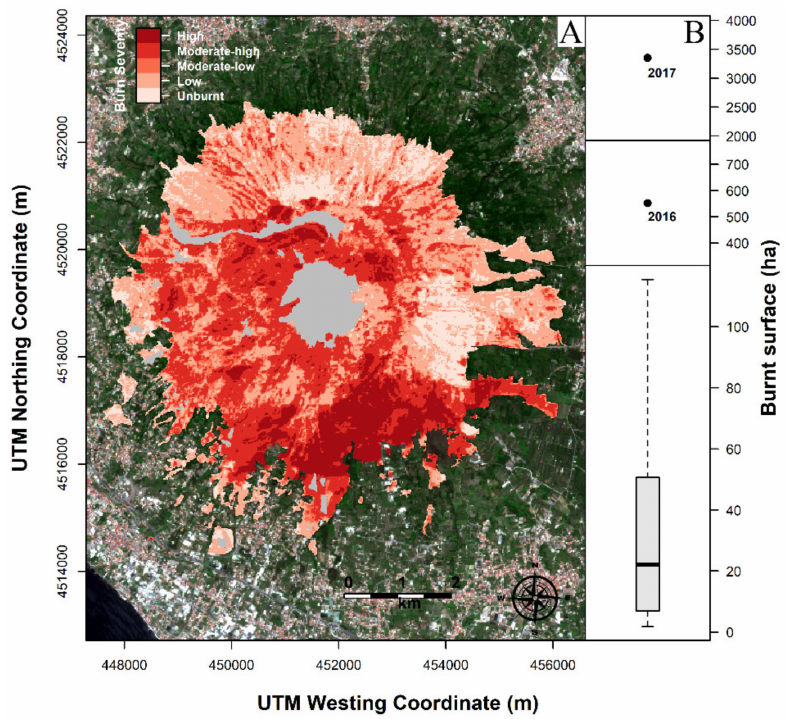
Figure 2. Burn severity map of the wildfires that occurred in summer 2017 (panel ( A )). On the right box plot of 20-year historical data for the annual burnt surface area from 1997–2017 in the forest area of Vesuvius National Park (panel ( B )). The outliers in 2016 and 2017 can be classified as megafires, according to DellaSala and Hanson [25]. Grey polygons represent non-forested areas (i.e., the main volcano cone, secondary adventitious cones, and lava